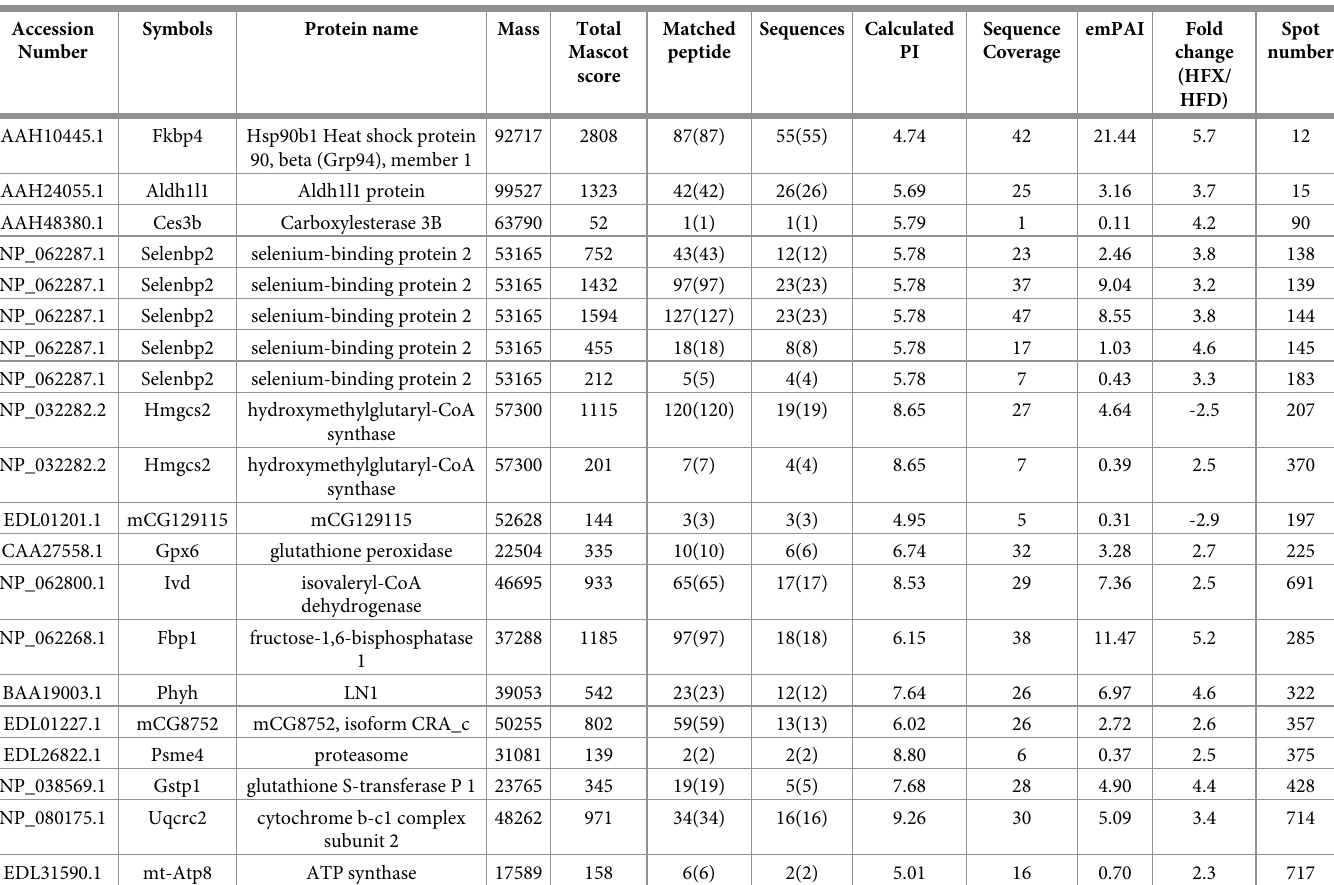
Table 3. Liver proteins differentially expressed in the HFX vs.